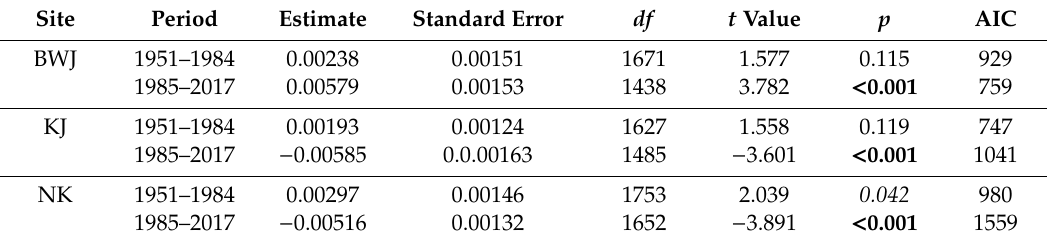
Figure 6. Temporal variation in ring-width synchrony (within-group â c ) of P. latteri for three sites (BWJ, KJ and NK) in Thailand, estimated within 30-year windows incremented by 5 years during the period 1951–2017. The shaded areas indicate change in the standard error of synchrony. Table 2. Summary of linear mixed-e ff ects models for long-term trends of log-transformed BAI residuals (log BAI residuals) for the periods 1951–1984 and 1985–2017 for three study sites (BWJ, KJ, NK) in Thailand. Linear mixed-e ff ects models were built for each period and each site, with log BAI residuals as dependent variable, year as fixed factor and individual tree as random factor. Significance at p < 0.05 and p < 0.01 levels are in italic and bold respectively. AIC: Akaike’s Information